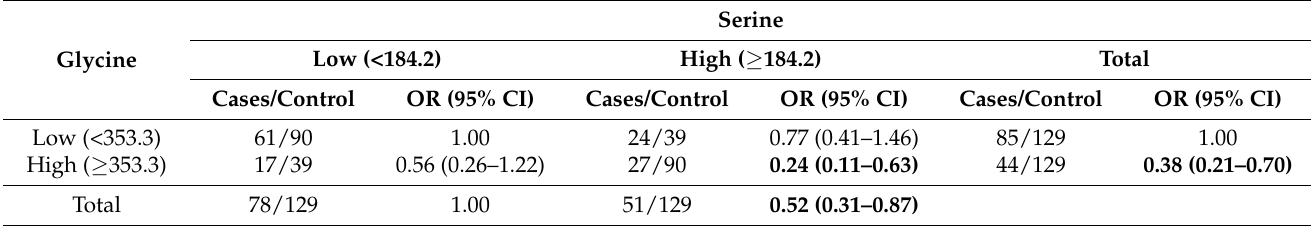
Table 4. Joint effect of serine and glycine on the risk of pancreatic cancer in the Shanghai Cohort Study a .